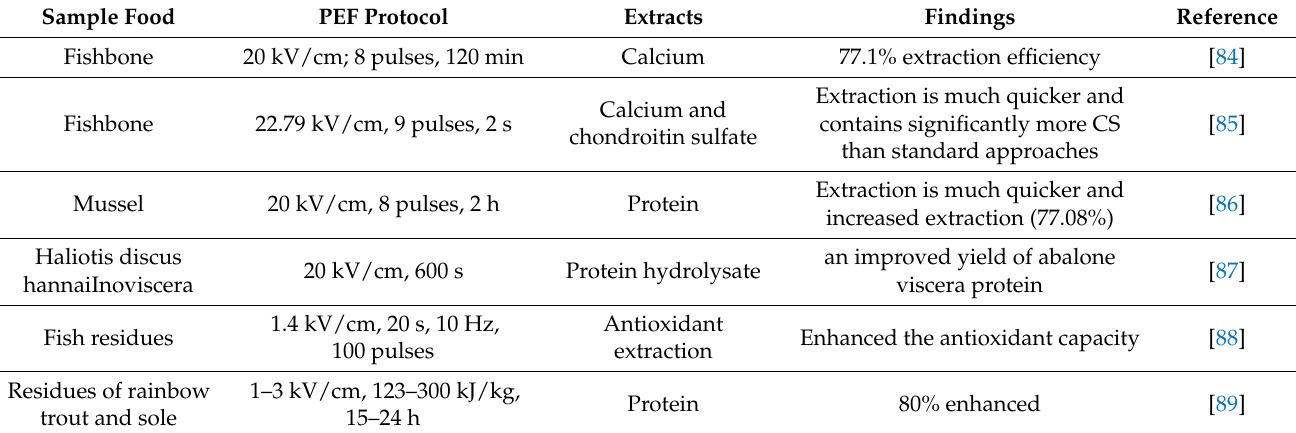
Table 3. Examples of applications of PEF for extraction purposes in